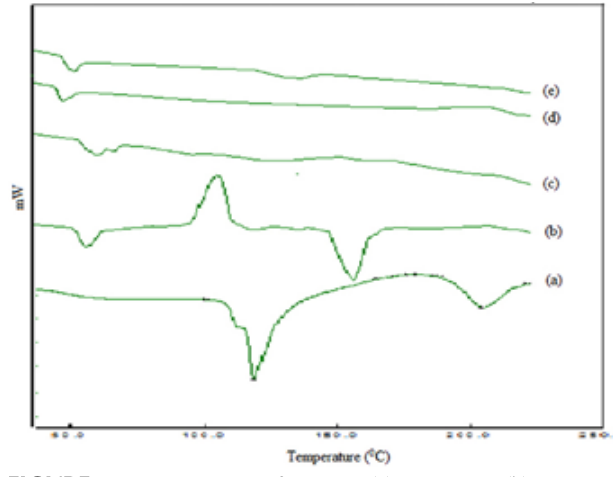
FIGURE 3 - DSC spectra of (a) Pure TDF; (b) Pure PLA R203H; (c) TDF-PLA R203H ACNs; (d) Pure PLGA RG503H; (e) TDF-PLGA RG503H